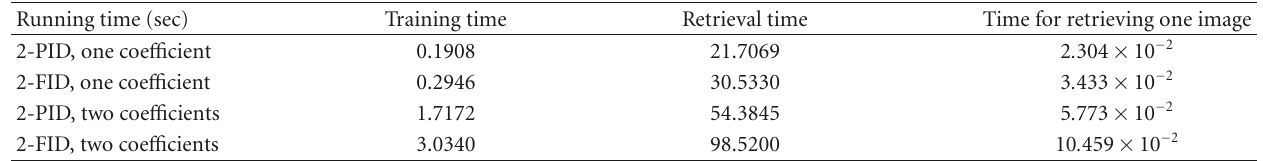
Table 10: Running times of 2 subarea